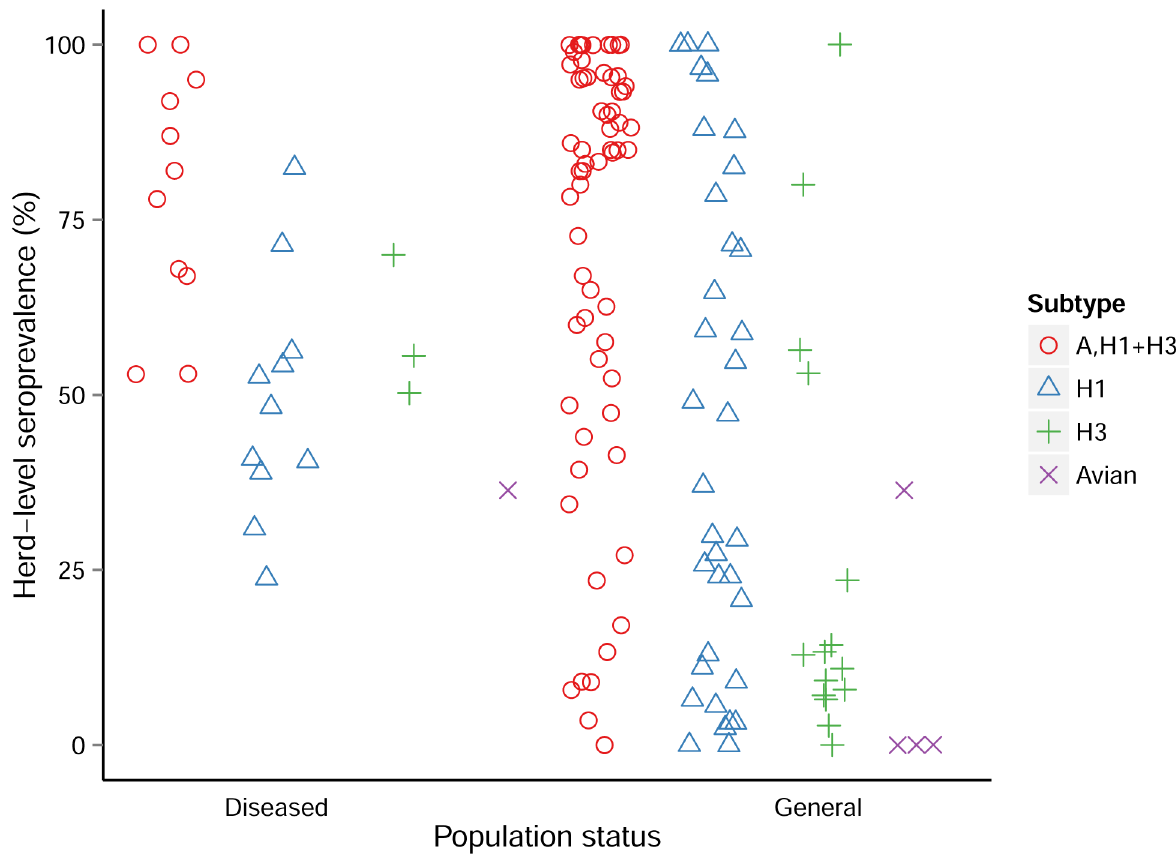
Fig 6. Herd-level seroprevalence distribution by health status and subtypes. N = 51 articles, 112 studies, 143 entries.